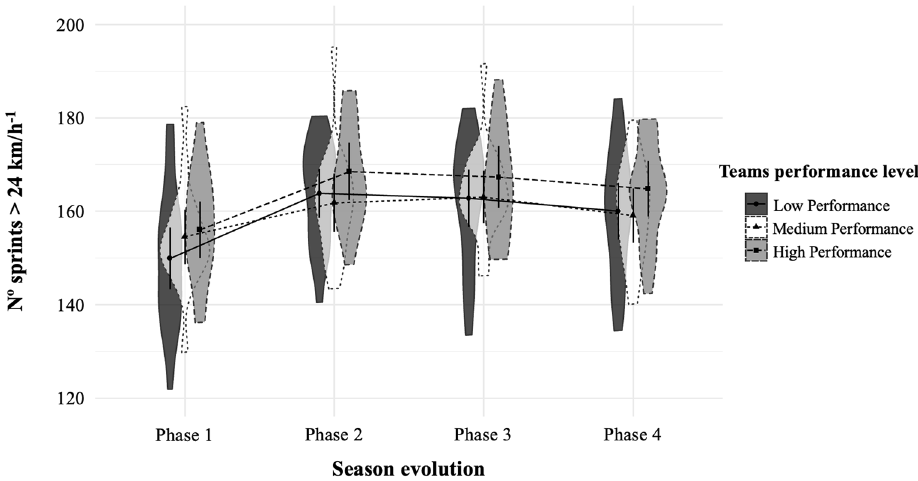
Figure 6. Number of sprints > 24 km h −1 registered ( M ± SD ) by teams with high, medium and low performance in the different phases of the seasons 29